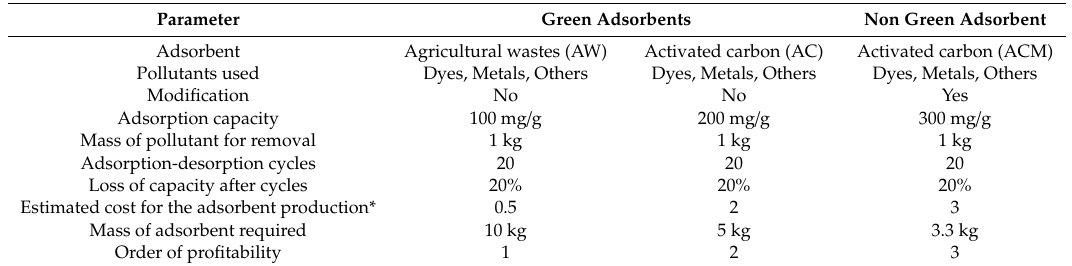
Table 8. Techno-economical comparison for green and non- green adsorbents.